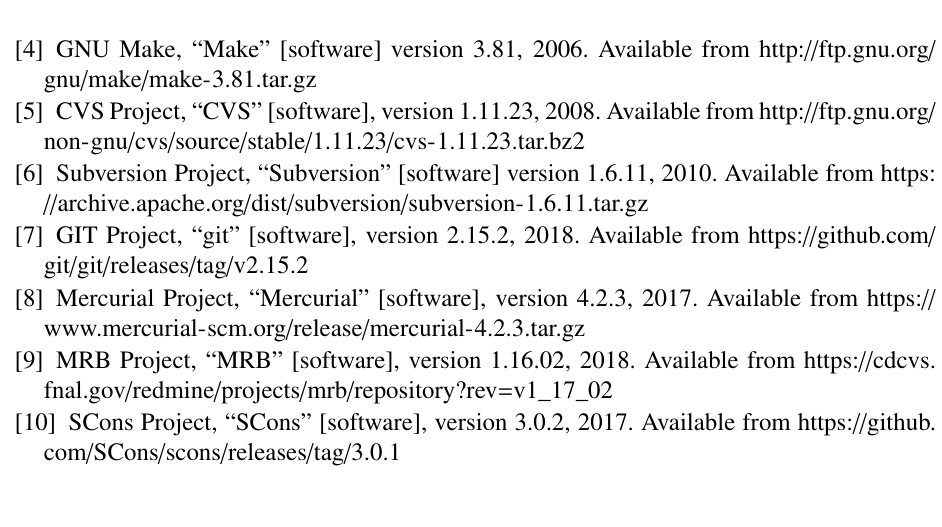
Figure 4. CI validation